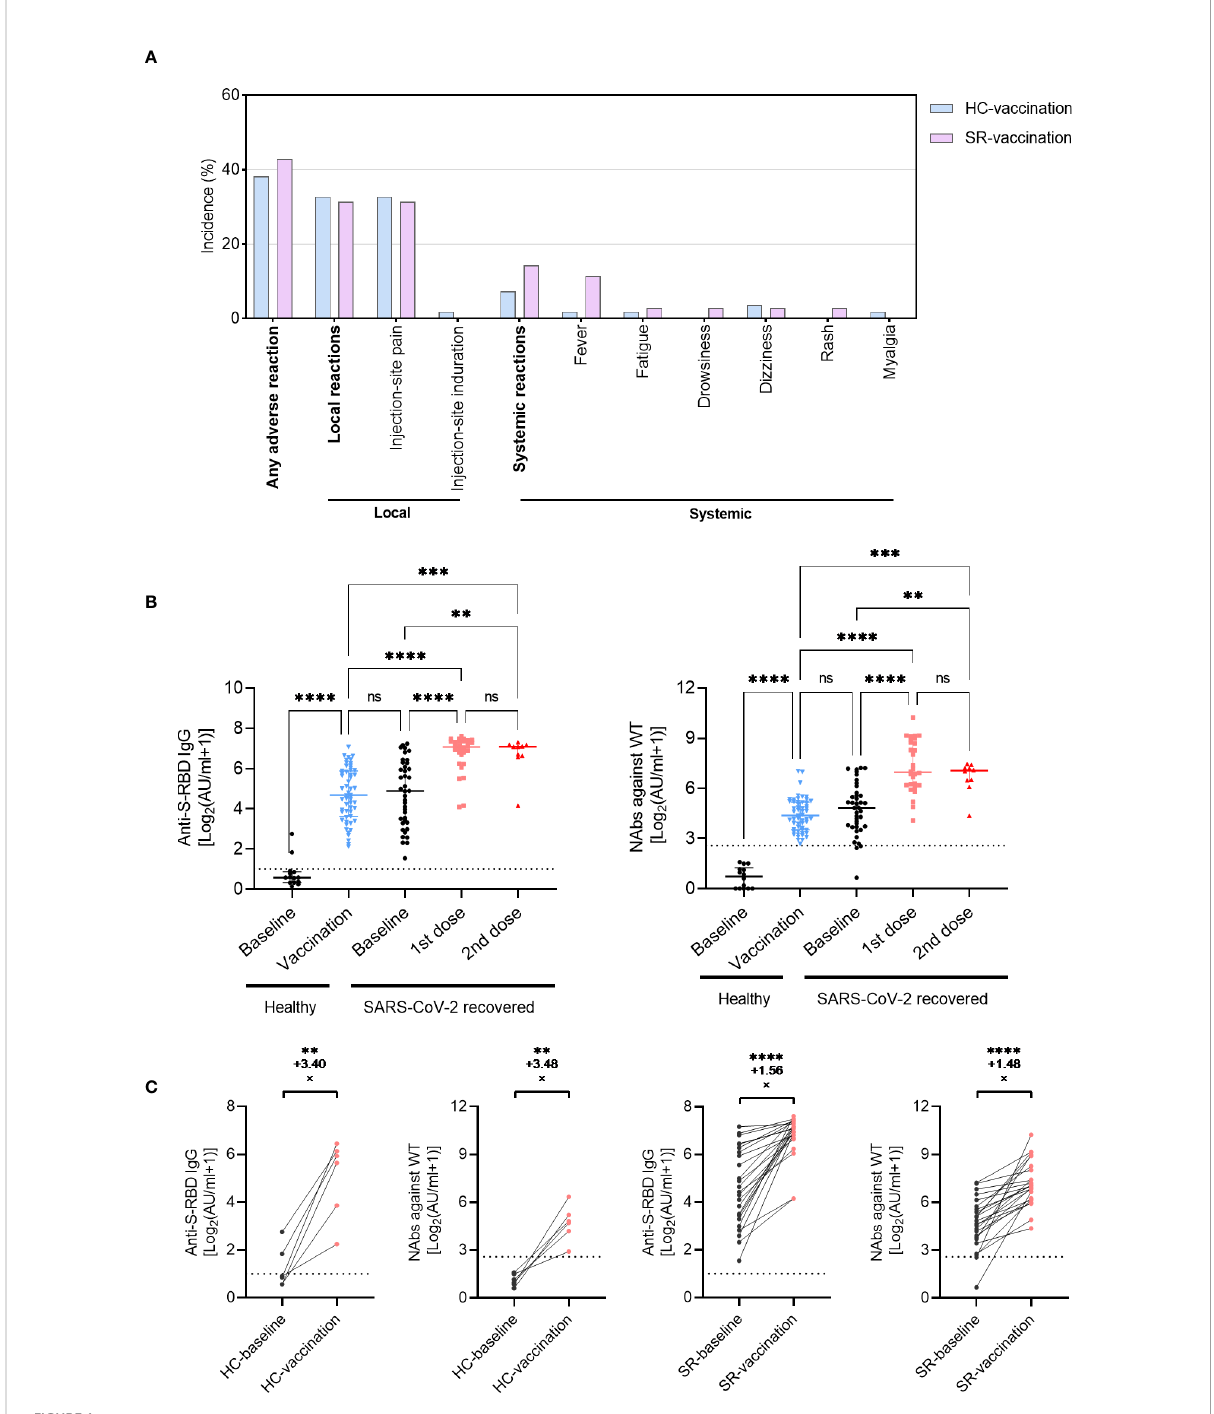
FIGURE 1 Antibody responses following inactivated vaccination in SARS-CoV-2 recovered patients (SR) and healthy individuals (HC). (A) The incidence of adverse reactions after vaccination in SR (N=35) and HC (N=55) patients. (B) The titer of anti-S-RBD-IgG and NAbs (WT) before or after vaccination in SR (baseline, N=40; vaccination, N=40 with 1st dose, N=30; 2nd dose, N=10) and HC (baseline, N=14; vaccination, N=55) group. Data are shown with median and IQR. (C) The fold-change of anti-S-RBD-IgG and NAbs increased pre- (black) and post- (red) vaccination in paired HC (N=6, paired data) and SR (N=24, paired data) individuals. The horizontal dotted line or shadow represented the cut-off value. The Kruskal-Wallis test followed by Dunn ’ s multiple comparisons test (B) and paired t-test (C) were used for statistical analysis. ns, no signi fi cance, ** P <0.01, *** P < 0.001, **** P <